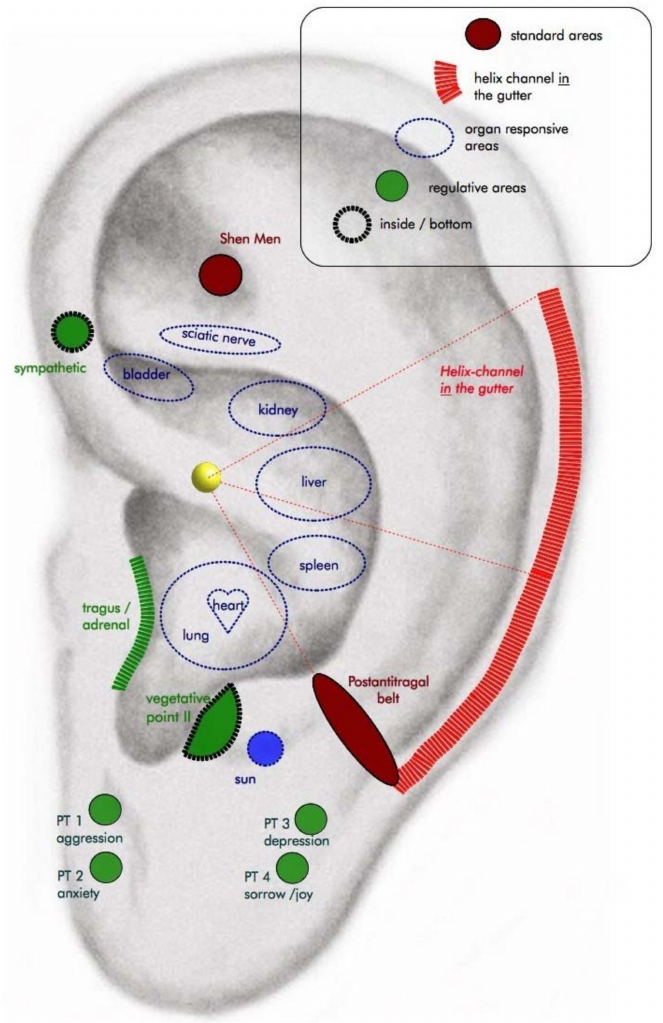
Figure 1. Insomnia auricular acupuncture protocol (adapted from Yase-Institut, Teaching institute for auricular acupuncture, Oldenburg,